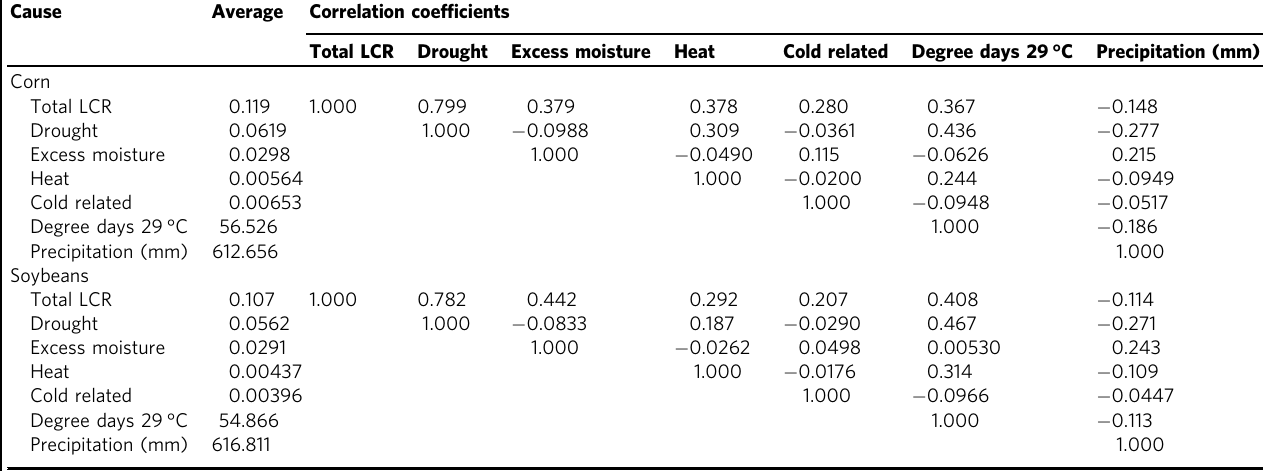
Table 1 Summary statistics for LCR, temperature, and precipitation variables, 1989 – 2014.